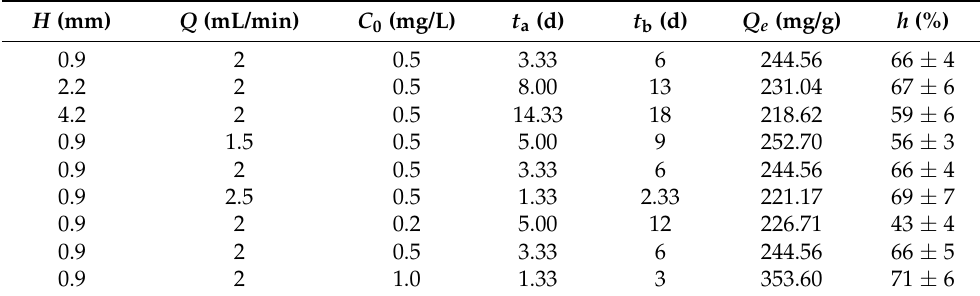
Figure 8. Effect of bed height on TCS penetration curve. Table 3. Calculation parameters for different bed heights.